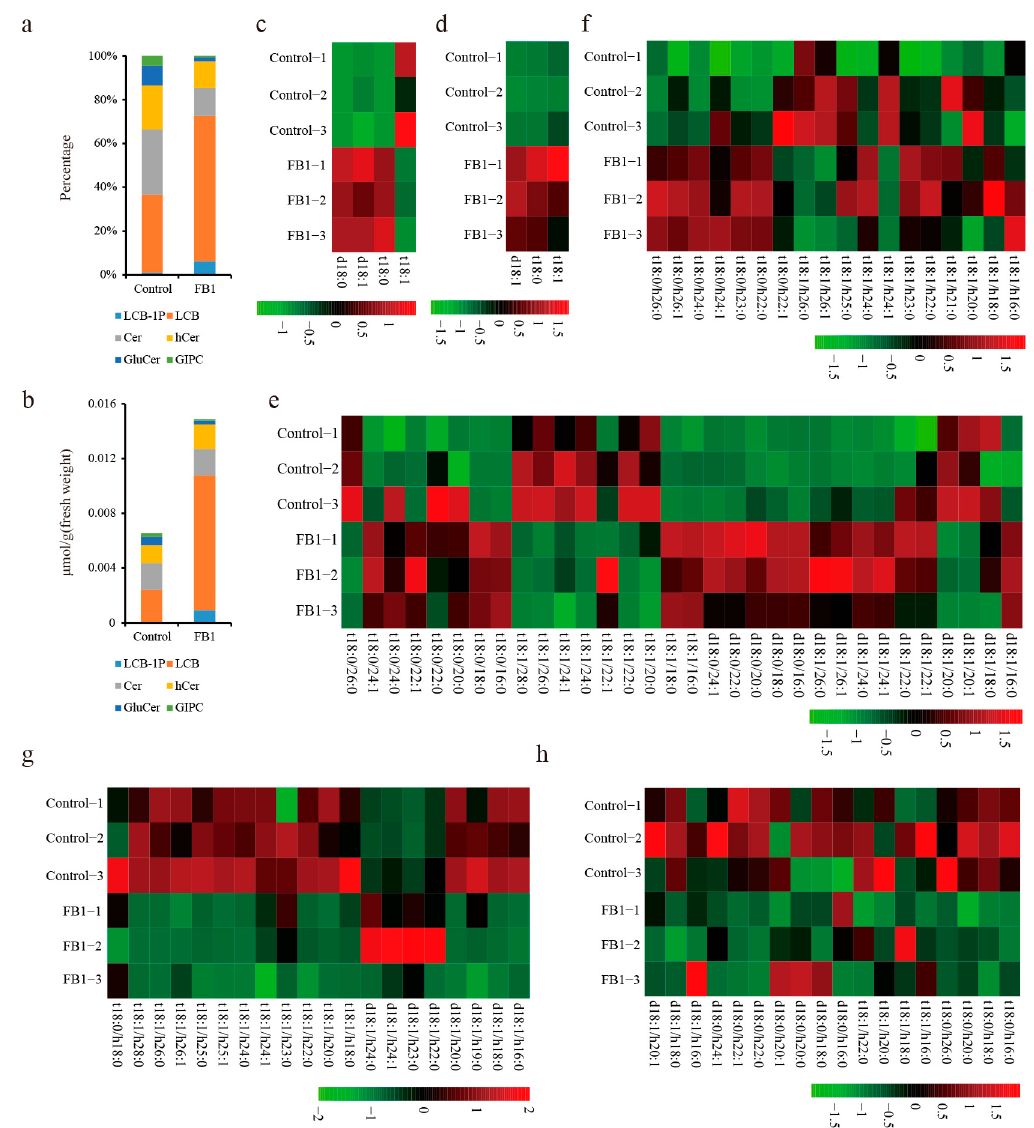
Figure 2. Changes in the sphingolipid content between the control and the FB1 samples. ( a ) Percentages of the six major categories of sphingolipids in the control and FB1 sample cultured 10 days. ( b ) The total content of six major sphingolipid categories in control and the FB1 sample cultured 10 days. ( c – h ) Heat map of the individual sphingolipids between the control and the FB1 sample cultured 10 days. c, LCB-1P; d, LCB; e, Cer; f, hCer; g, GluCer; h, GIPC.